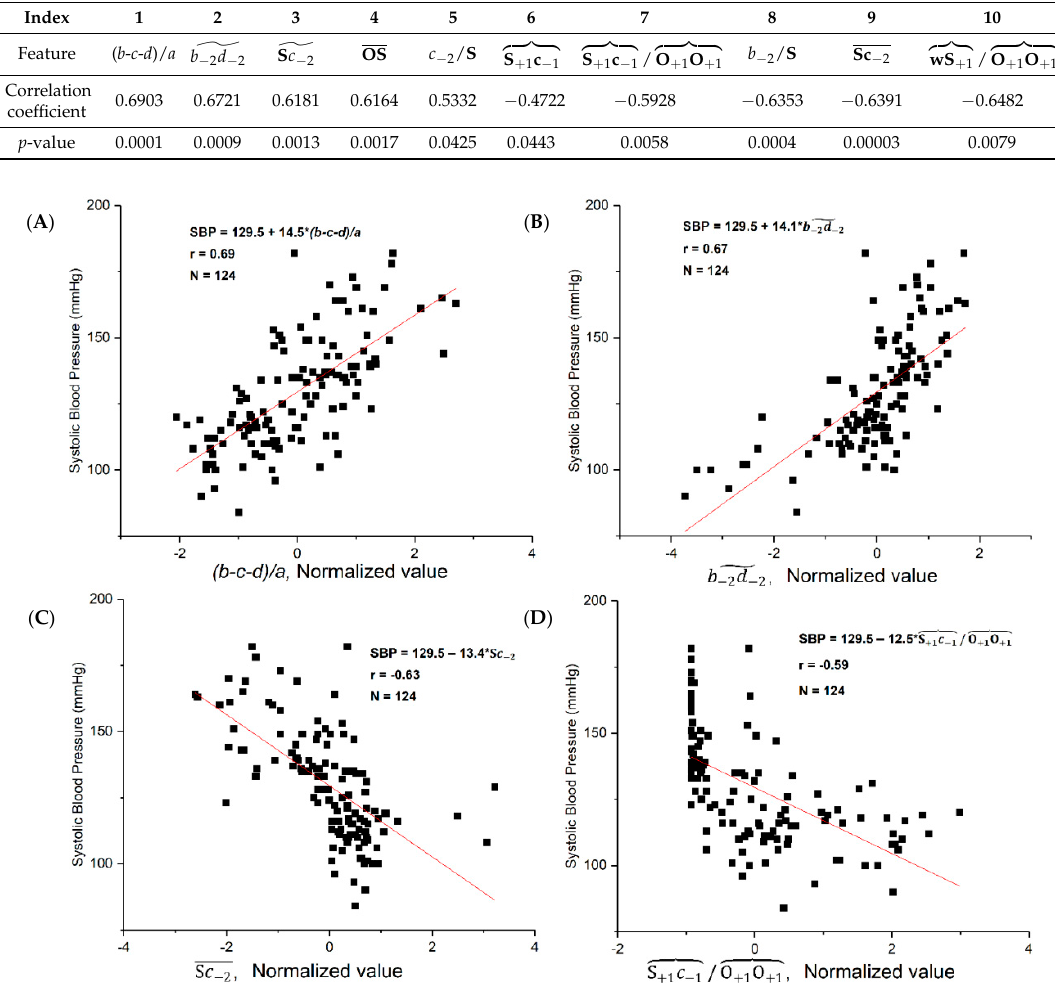
Figure 4. The regression analysis of the four features with the strongest correlation with systolic blood pressure (SBP). (A) ( b - c - d )/ a (B) 𝒃